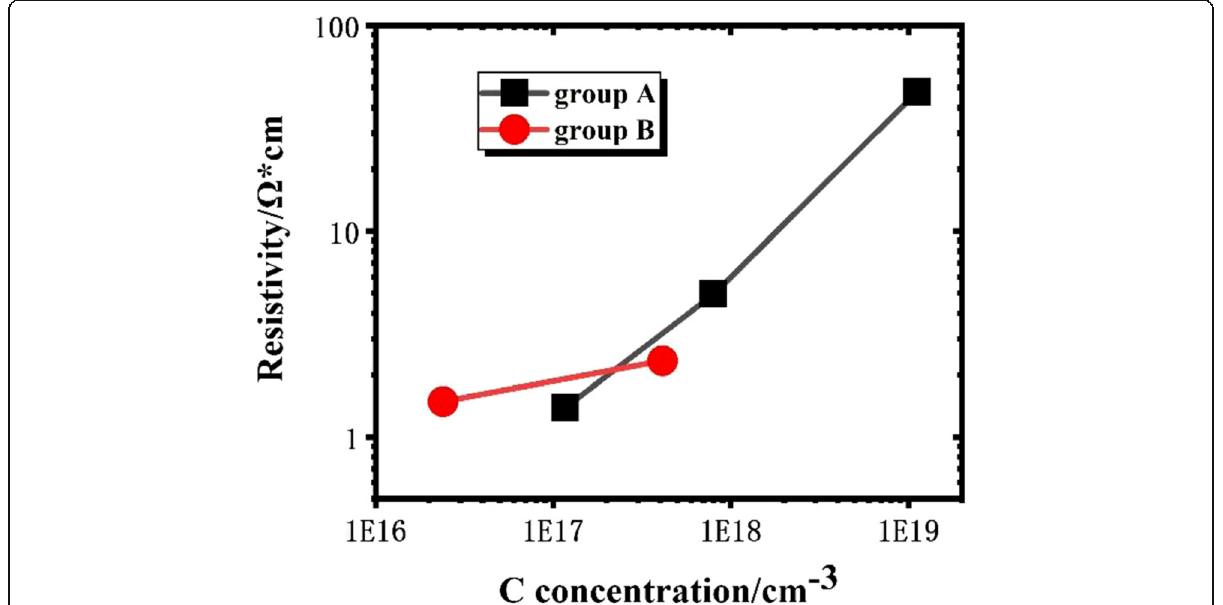
Fig. 1 The resistivity of samples changes with the C concentration in groups A and